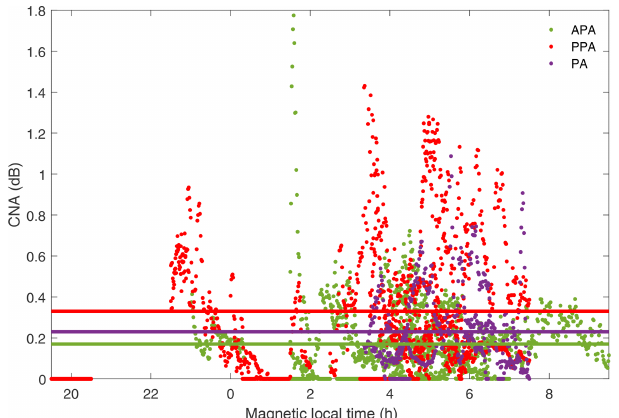
Figure 7. KAIRA cosmic noise absorption (CNA) during different types of pulsating aurora. Color-coded horizontal lines are the aver- age CNA for respective PsA